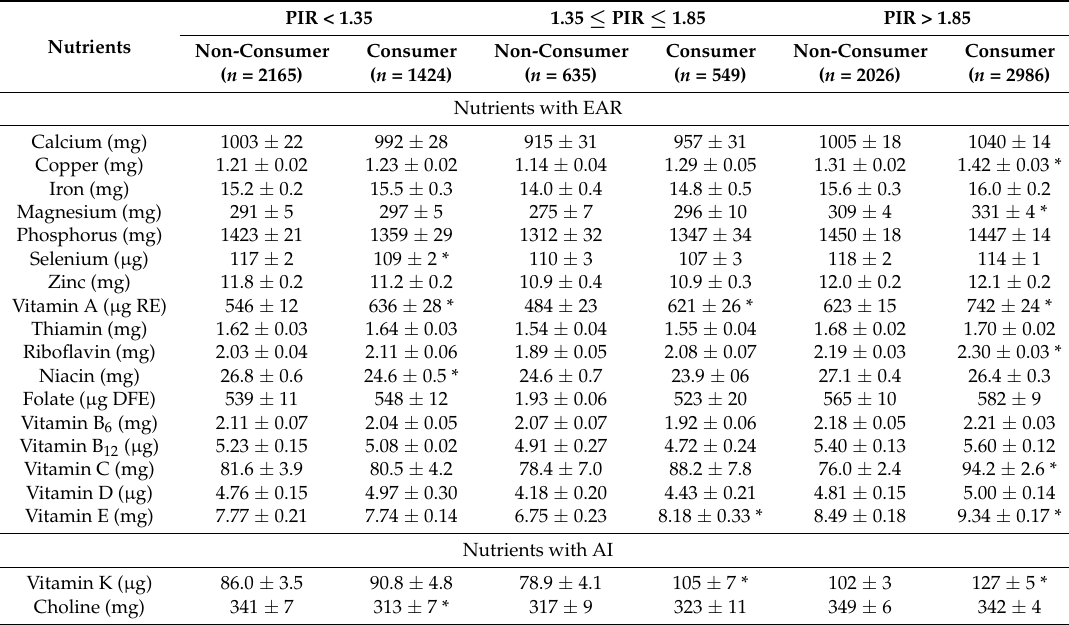
Table 1. Usual intake of nutrients from foods only among adults (19+ years old) by PIR groups. NHANES 2009–2012, gender combined data.